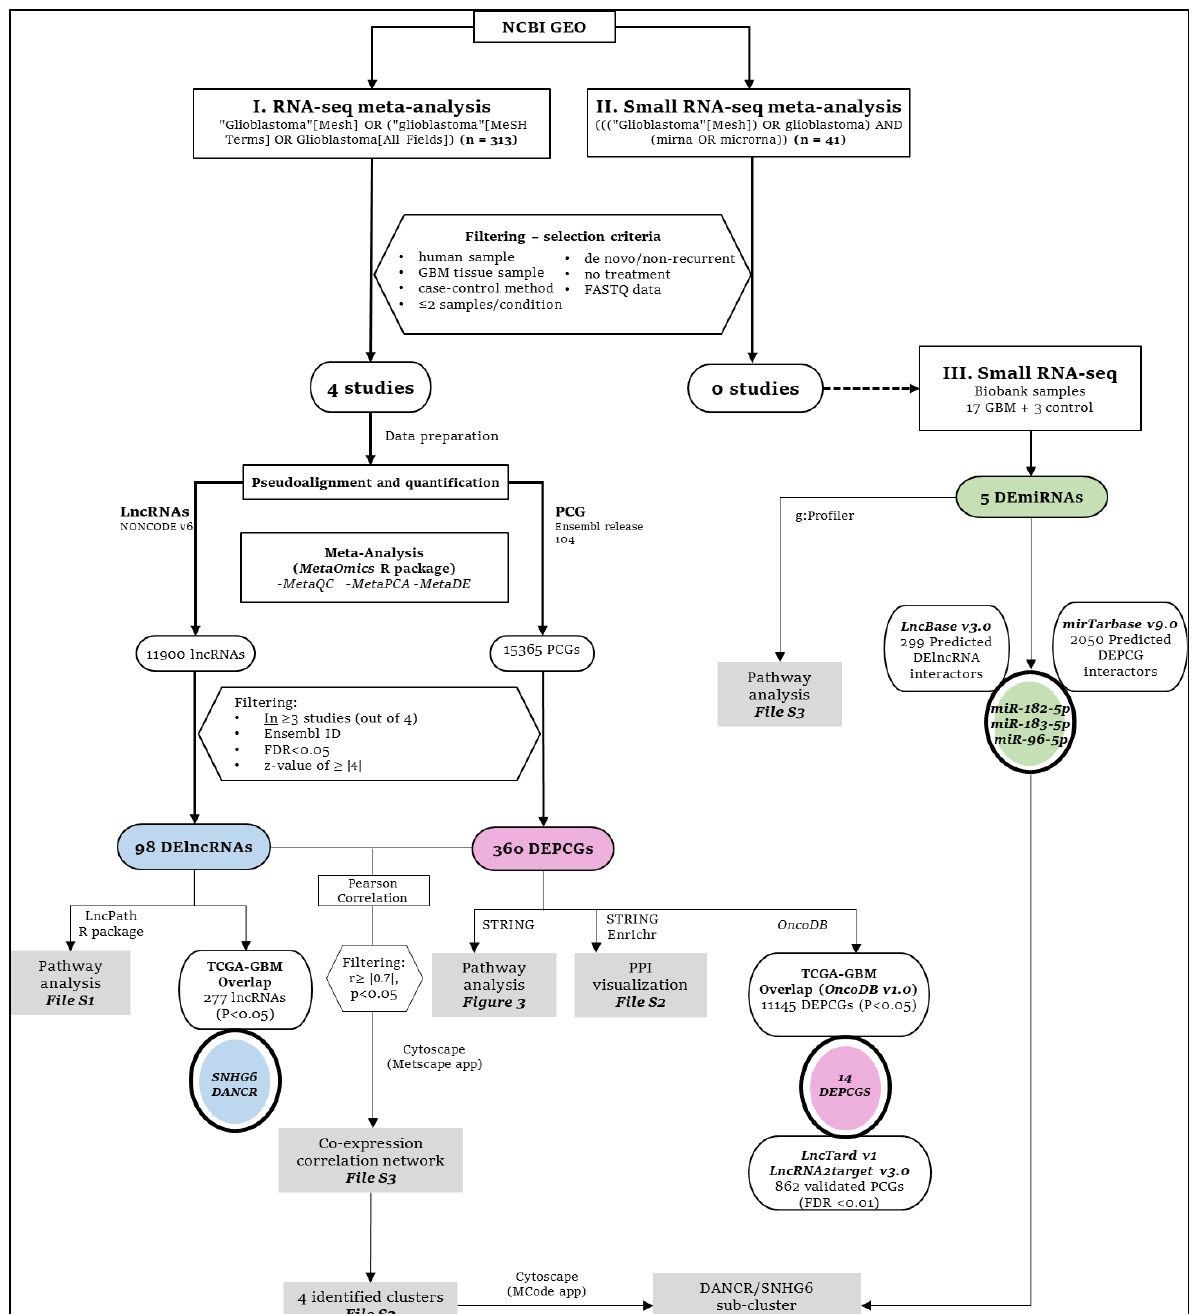
Figure 1. Schematic flow chart of the methodology used in this study. The workflows for lncRNAs, PCGs and miRNAs are denoted via blue, pink and green colors, respectively. Black circles indicate intersection/overlap output with databases. ( I and II ) Employed methodology for meta-analysis of glioblastoma tissue RNA-seq and small RNA-seq datasets, respectively. Four studies were selected for RNA-seq meta-analysis with identification of DElncRNAs and DEPCGs, and their overlap with experimentally verified databases and TCGA-GBM. No qualifying studies could be included in small RNA-seq meta-analysis and thus small RNA-seq ( III ) was performed on glioblastoma tissues (n = 17) and normal tissue controls (n = 3) for identification of DEmiRNAs and overlap with predicted miRNA targets of DElncRNAs and DEPCG. Downstream analyses performed on the filtered DElncRNAs, DEPCGs and DEmiRNAs are detailed further with corresponding figures/supplementary files including pathway analyses, protein-protein interactions (PPIs) and co-expression